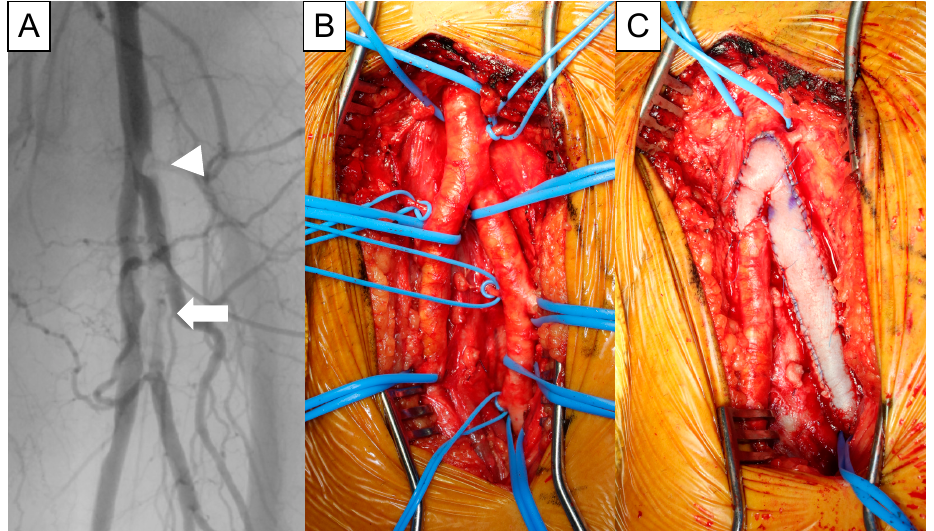
Figure 4. Common femoral endarterectomy with extended profundaplasty using a bovine pericardial patch. ( A ) Trans-arterial angiography of the left femoral artery. Stenosis at common femoral artery (arrowhead) and occlusion of deep femoral artery (arrow). ( B ) Intraoperative picture of the left femoral artery. ( C ) Reconstruction by patch-angioplasty using a bovine pericardial patch.